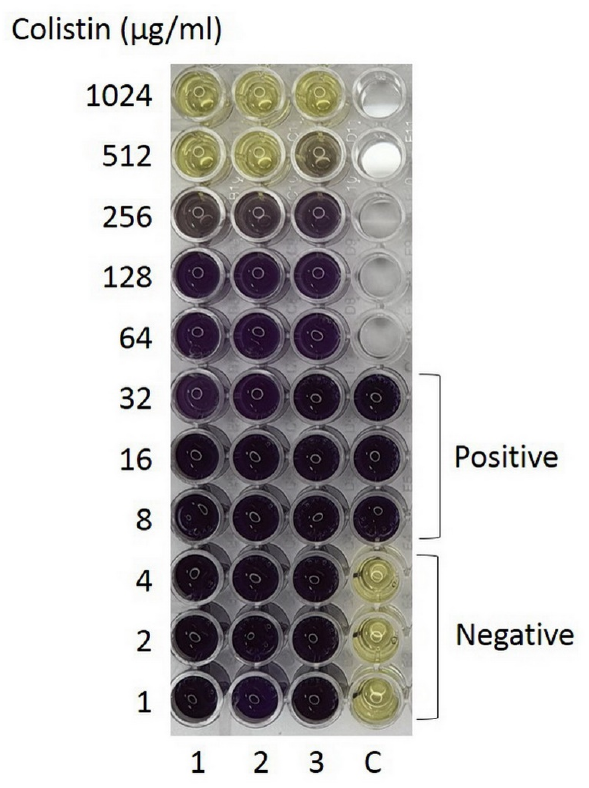
Figure 1. Minimum inhibitory concentration (MIC) determination by microdilution assay using MTT staining. Aci46 viable cells and positive control are shown in purple while dead cells or negative control are shown in yellow. The experiments were tested with three biological